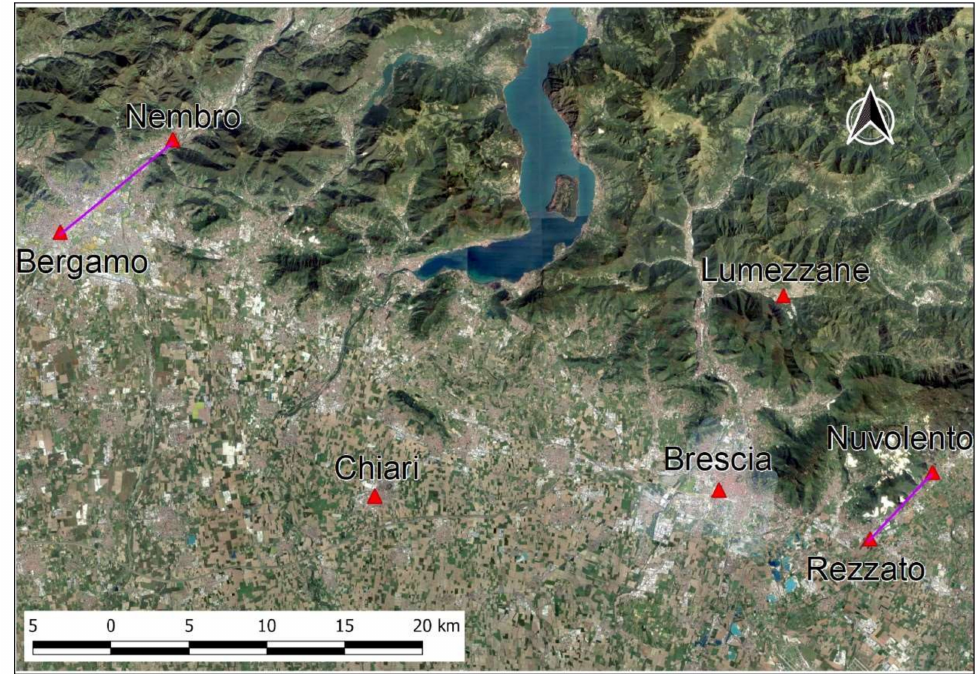
Figure 8. Location of the Seriana (Nembro) and Chiese (Nuvolento) valleys. The purple lines highlight that the two valleys are parallel to each other. Basemap Google